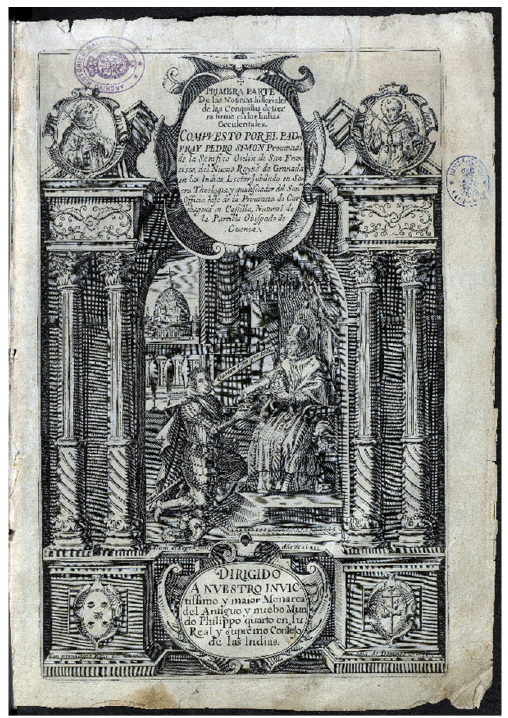
Figure 11. Alardo de Popma. Felipe IV entrega la cuarta corona al papa Urbano VIII . Book cover of Fray Pedro Simón, Primera parte de las noticias historiales de las Conquistas de tierra firme en las Indias Occi- dentales… En Cuenca en casa de Domingo de la Yglesia, [1627]. (Biblioteca Nacional de España).